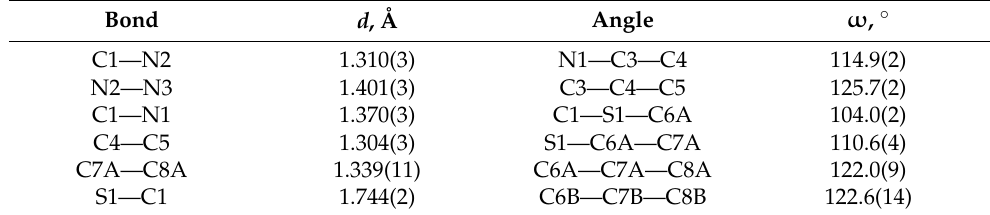
Figure 2. The independent part in Atr crystal structure. One of the two disordered positions of the allyl group, i.e., with the lower site-occupancy factor, is shown in semi-transparent mode. Displacement ellipsoids are drawn at the 50% probability level. Table 1. Selected geometric parameters (Å, ◦ ) of Atr